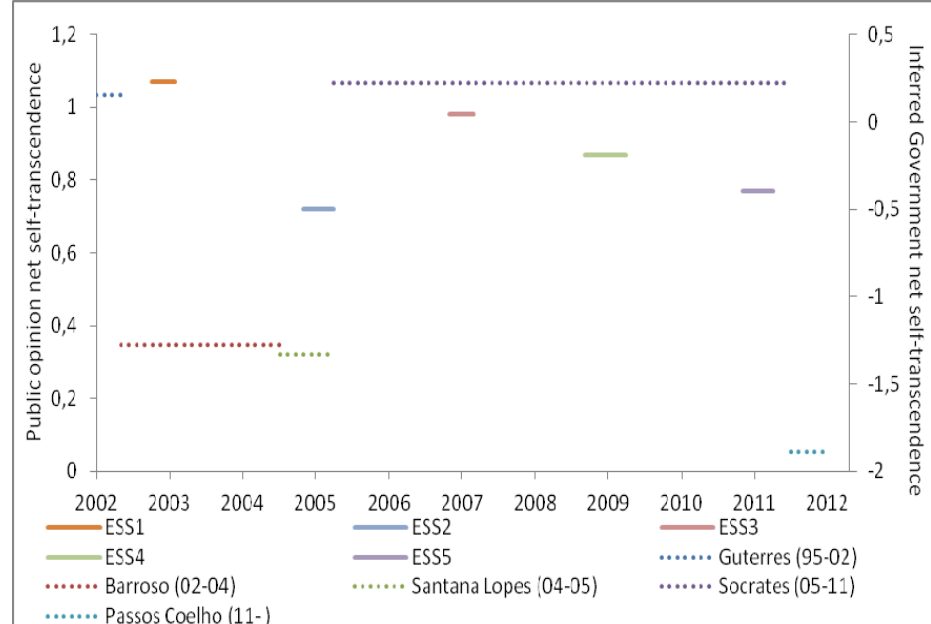
Figure 8: Net self-transcendence for